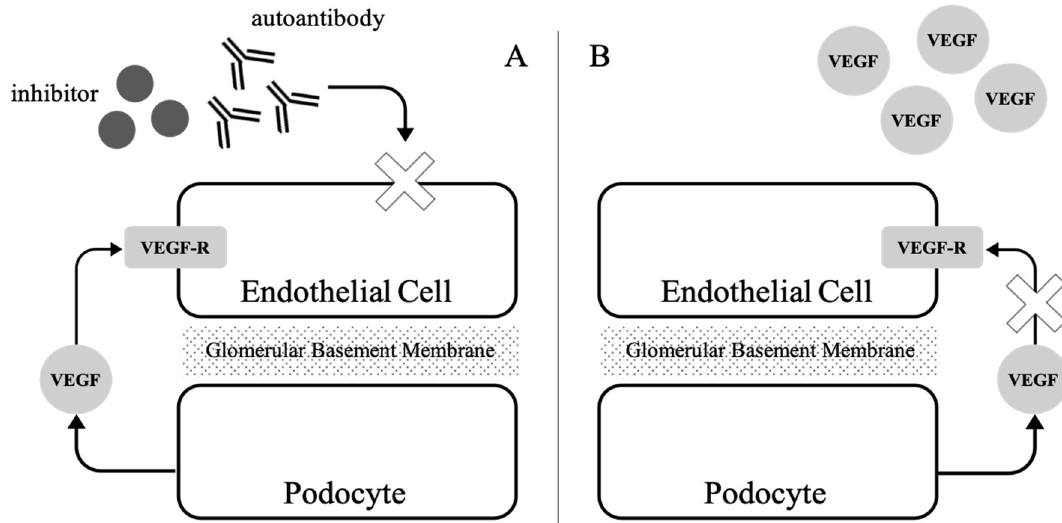
Figure 2. Proposed mechanism of renal thrombotic microangiopathy in a patient with TAFRO syndrome. ( A ). Circulating autoantibodies or cytokines produced by specific ( B ) lymphocyte clones within lymphadenopathy interfere with VEGF diffusion flux or directly act on vascular endothelial cells causing damage, ( B ). Elevated serum VEGF breaks the concentration gradient of VEGF across the glomerular basement membrane, impeding the nursing effect of VEGF produced by podocytes.